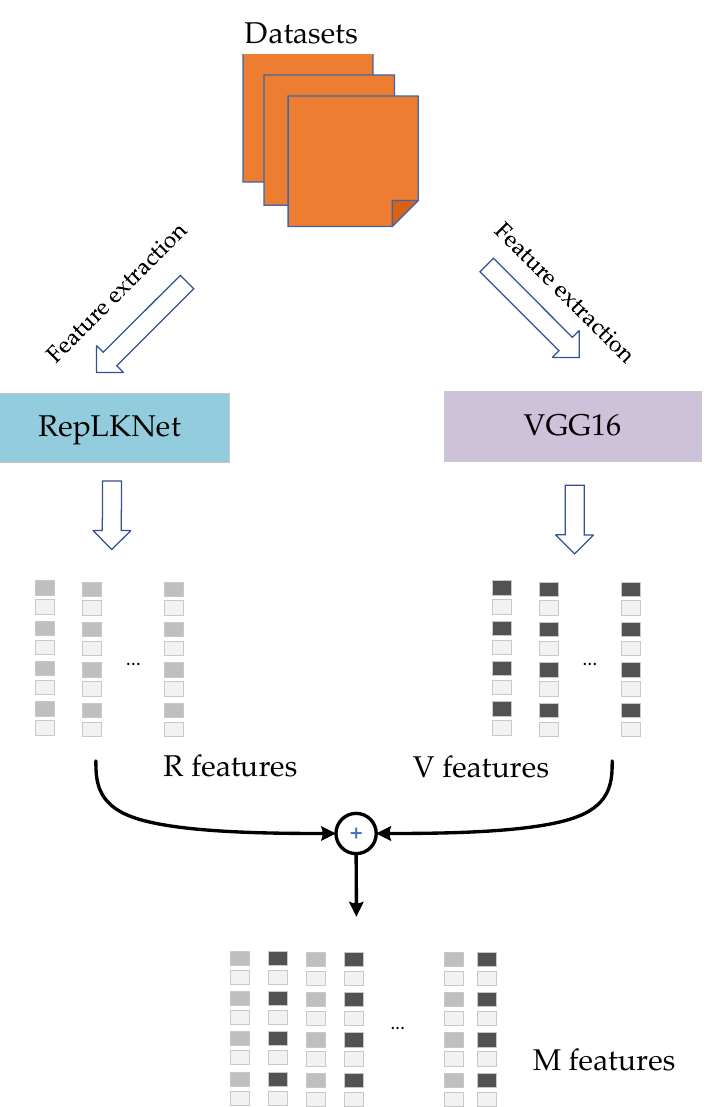
Figure 2. The mixed model. The RepLKNet model is adopted to extract the feature data of the images in the dataset, which are called R features. Similarly, the image data extracted by the VGG16 model are called V features. The R feature and the V feature are then mixed to obtain mixed feature data with different receptive field sizes, called M features.